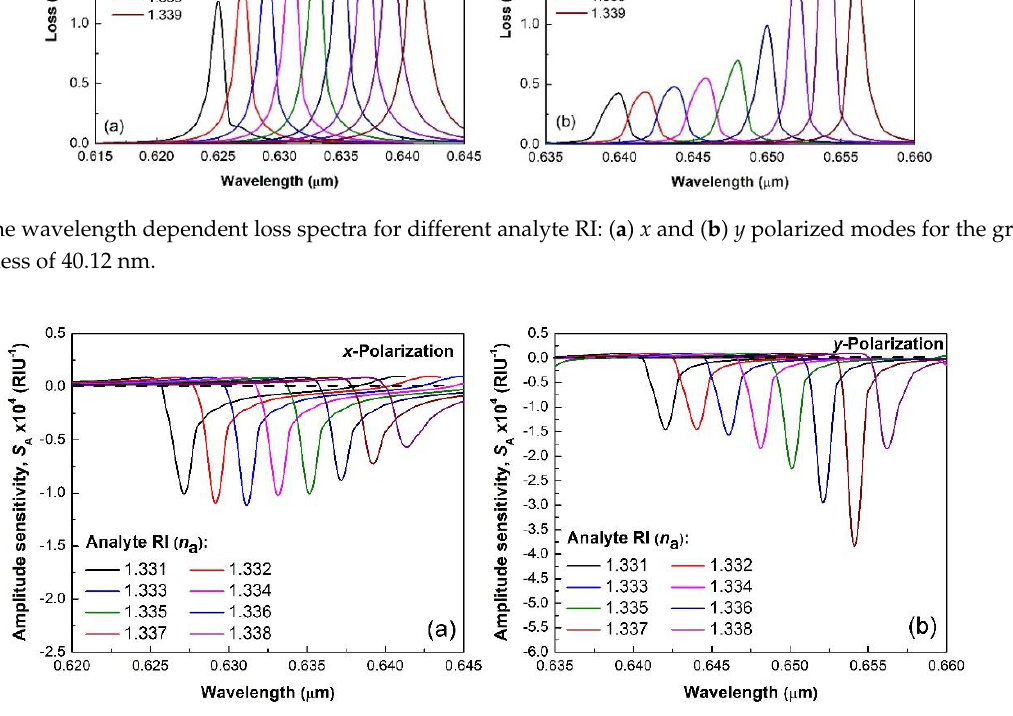
Figure 8. Amplitude sensitivity as a function of graphene layer thickness. Black points (square shape) and red points (circular shape) show the obtained results for x and y polarized modes.